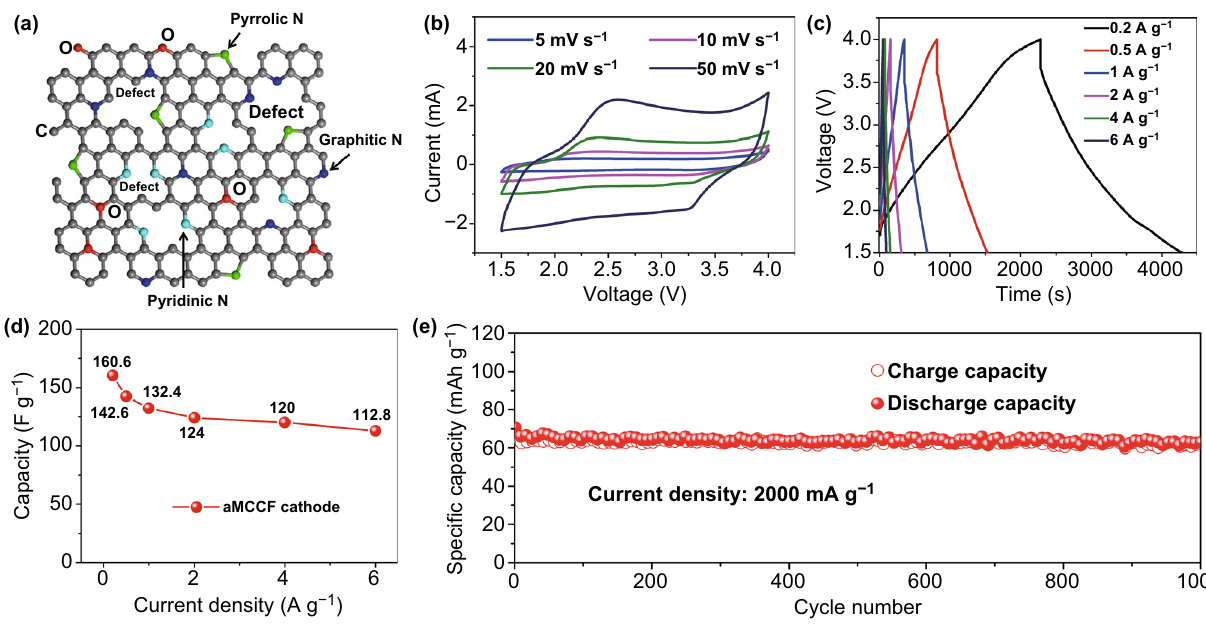
Fig. 4 a Schematic showing the atomic structure of the aMCCF. The electrochemical performance of the aMCCF electrode with respect to the PIBs: b CV curves at a scan rate of 5–50 mV s −1 , c Charge/discharge curves examined at a current density of 0.2–6 A g −1 , d Plot of the capacity versus current density for the aMCCF, and e Long-term cycling property at 2000 mA g −1 (excluding the data of the first